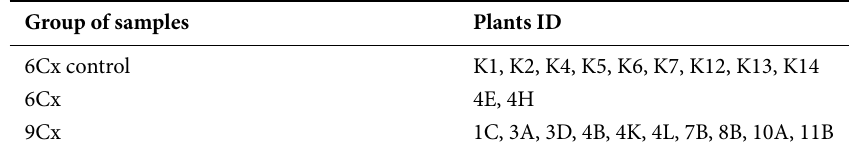
Table 1 Plants of Actinidia chinensis var. deliciosa chosen for analysis of stomatal traits; seedlings (6Cx control) and regenerated plants (6Cx and 9Cx).